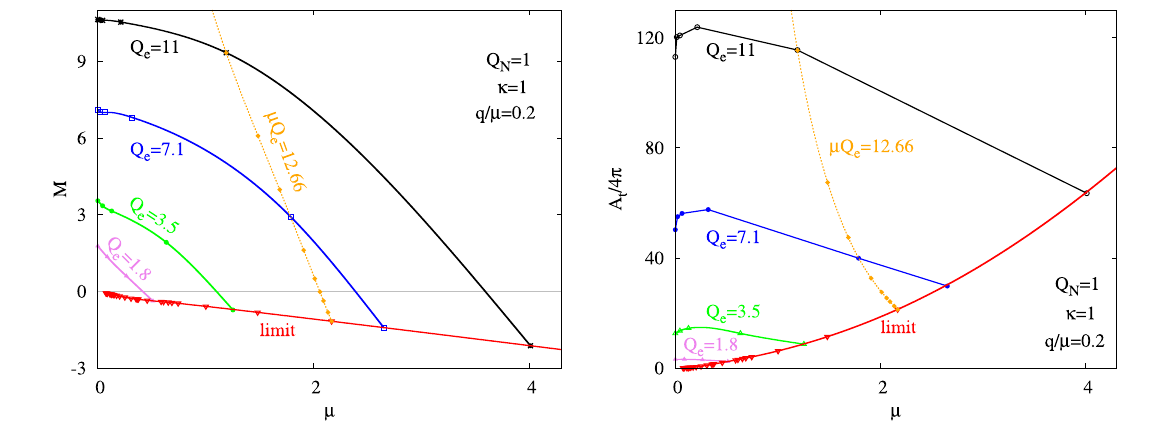
Fig. 7 (left) Mass M vs μ in Plank units for solutions with q /μ = 0 . 2. The color curves correspond to families of solutions with fixed electric charge ( Q e = 1 . 8 , 3 . 5 , 7 . 1 , 11 in pink, green, blue and black respec- tively). In red we show the limit configurations with w ∗ = − μ . In